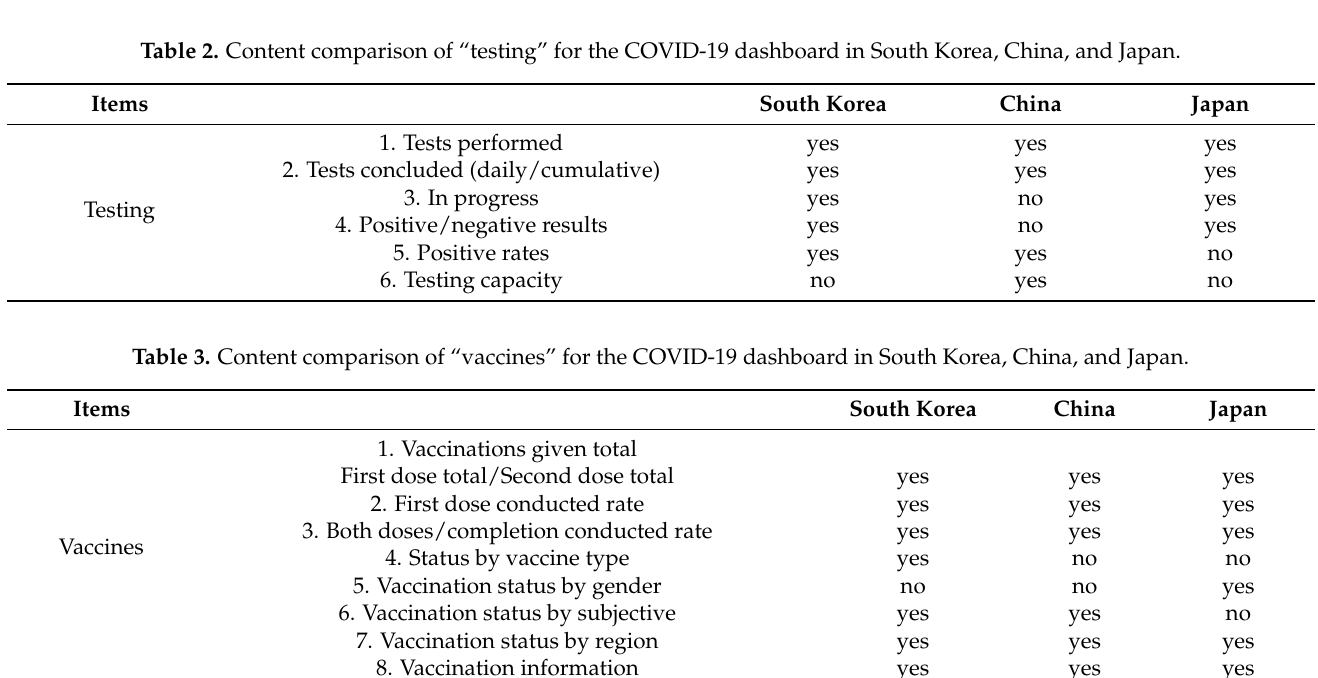
Table 2. Content comparison of “testing” for the COVID-19 dashboard in South Korea, China, and Japan. Items